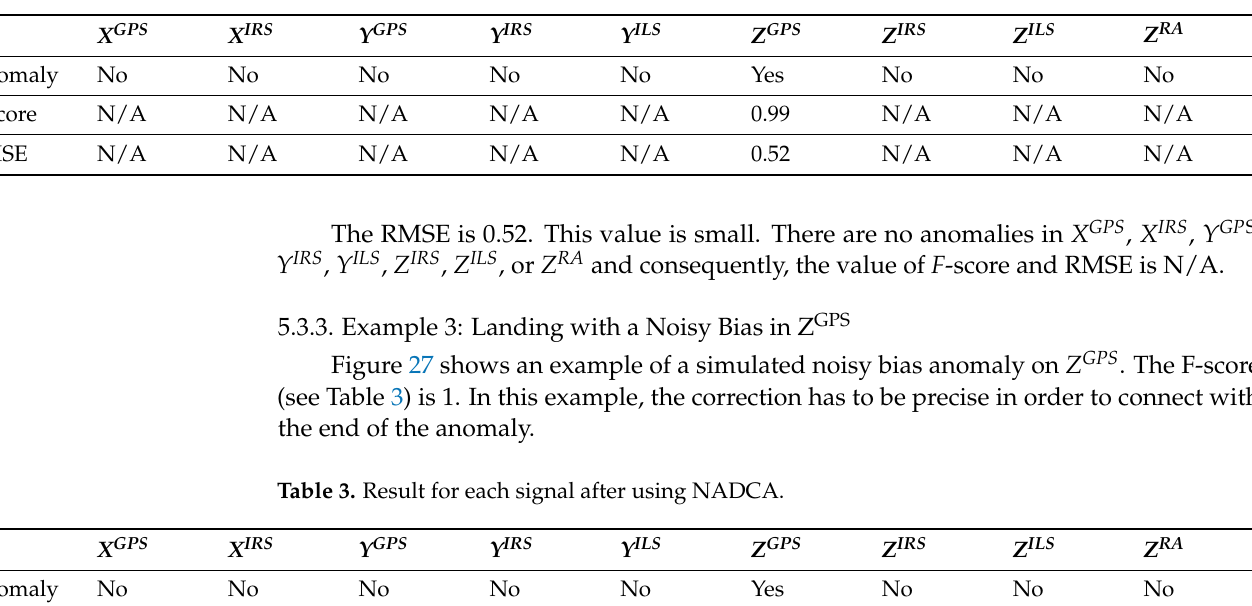
Figure 26. Noise anomaly detected and corrected on a specific landing using NADCA. Table 2. Result for each signal after using NADCA.